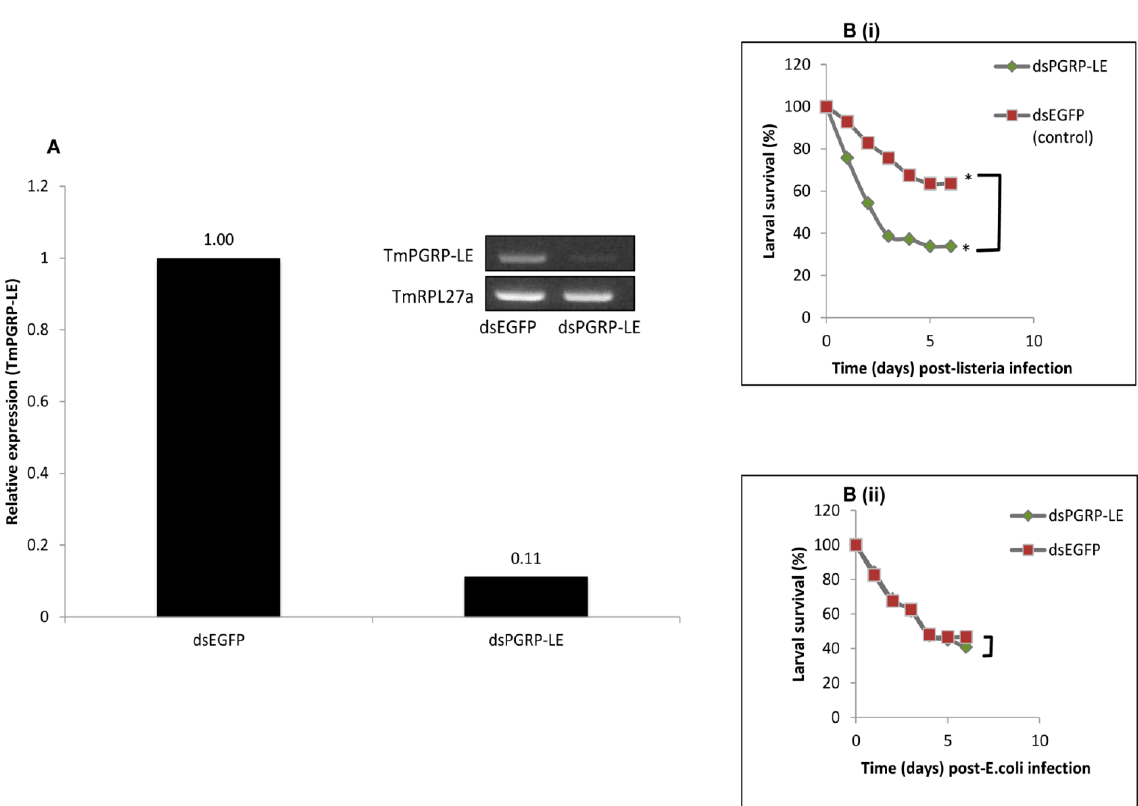
Figure 5. Effect of TmPGRP-LE knockdown on the survivability of T. molitor larvae ( A ) Silencing of TmPGRP-LE mRNA in the larvae of T. molitor by RNA interference. Real time qRT-PCR and semi-quantitative PCR methods were used to study the gene knockdown levels in the group injected with dsPGRP-LE prior to immune challenge by Listeria . The control group was injected with dsEGFP . A housekeeping gene TmRPL27a was used as an internal control during PCR reactions; ( B ) Survival pattern of T. molitor larvae following immune challenge by L. monocytogenes . Larvae whose gene expression was down regulated by RNAi exhibited a significant ( p < 0.05) (Wilcoxon-Mann-Whitney test) reduction in survivability as compared to the control group “*” represent a statistically significant difference between means ( B - i ); Replacing L. monocytogenes with E. coli did not result in the differential survival pattern observed with the intracellular pathogen L. monocytogenes ( B - ii ). Results presented here are an average of three independent biological replicate